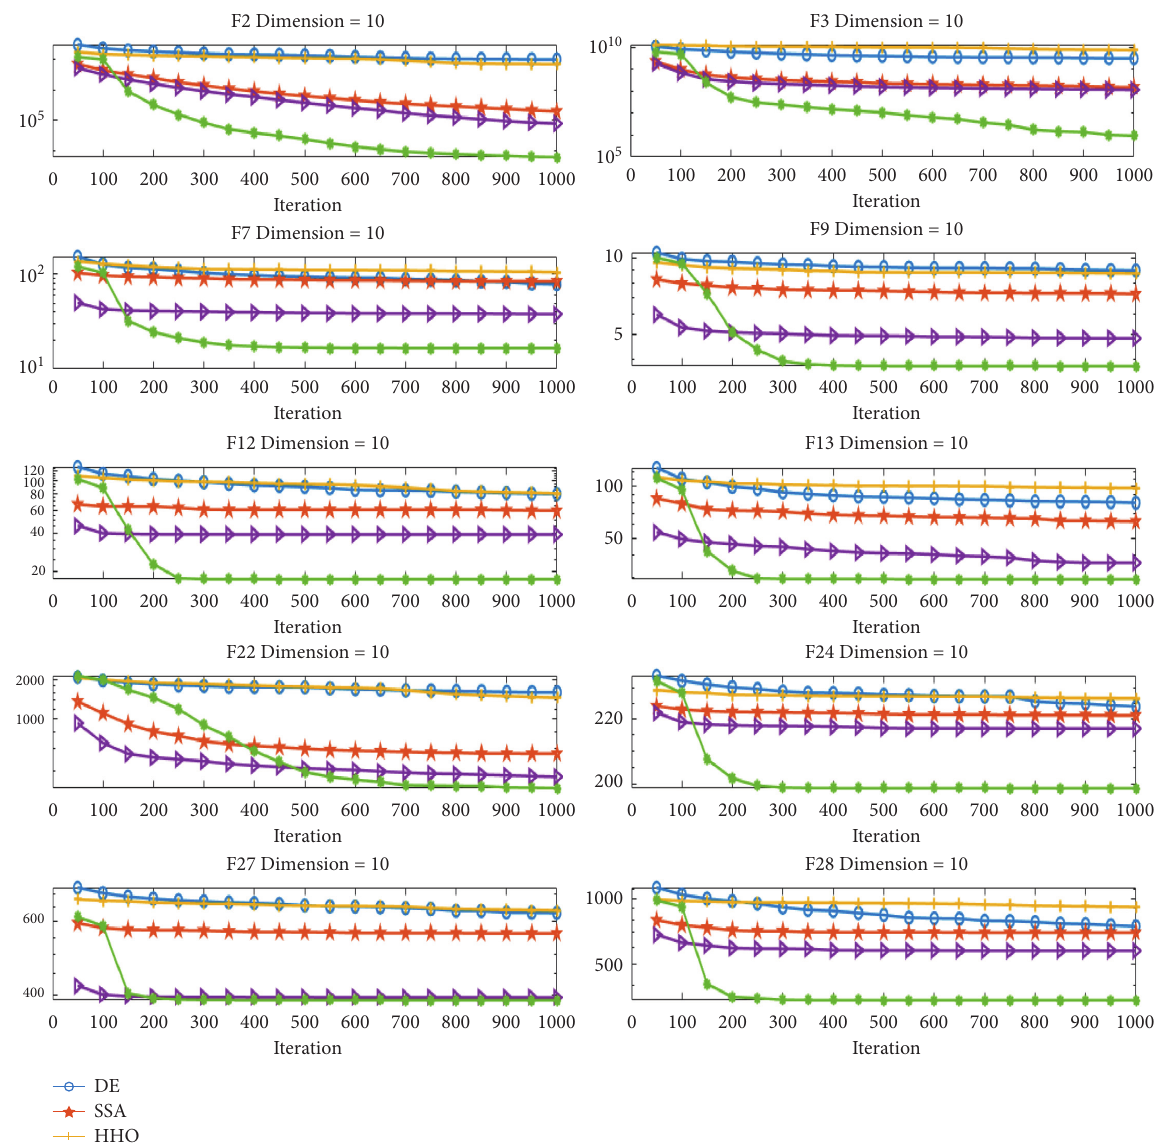
Figure 3: APPE’s convergence curve with the dimension of